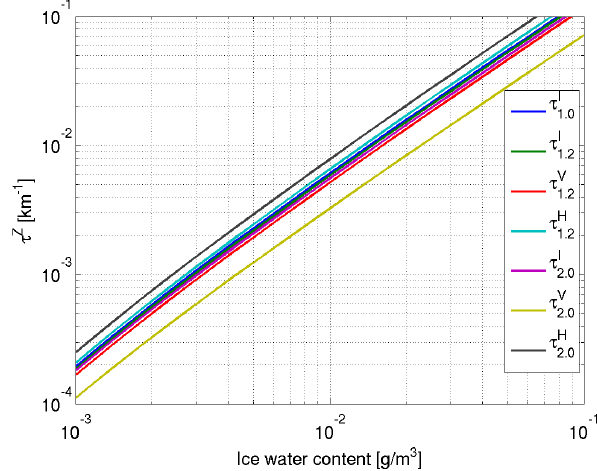
Fig. 10. Cloud ice optical paths for a 90 ◦ zenith angle and horizontally aligned oblate spheroids with an aspect ratio of 1, 1.2 and 2.0. Calculated with the PSD of MH97 and a temperature of 220 K . The different lines show the optical path for different aspect ratios and polarisation components (where I represents several components, as explained in text).